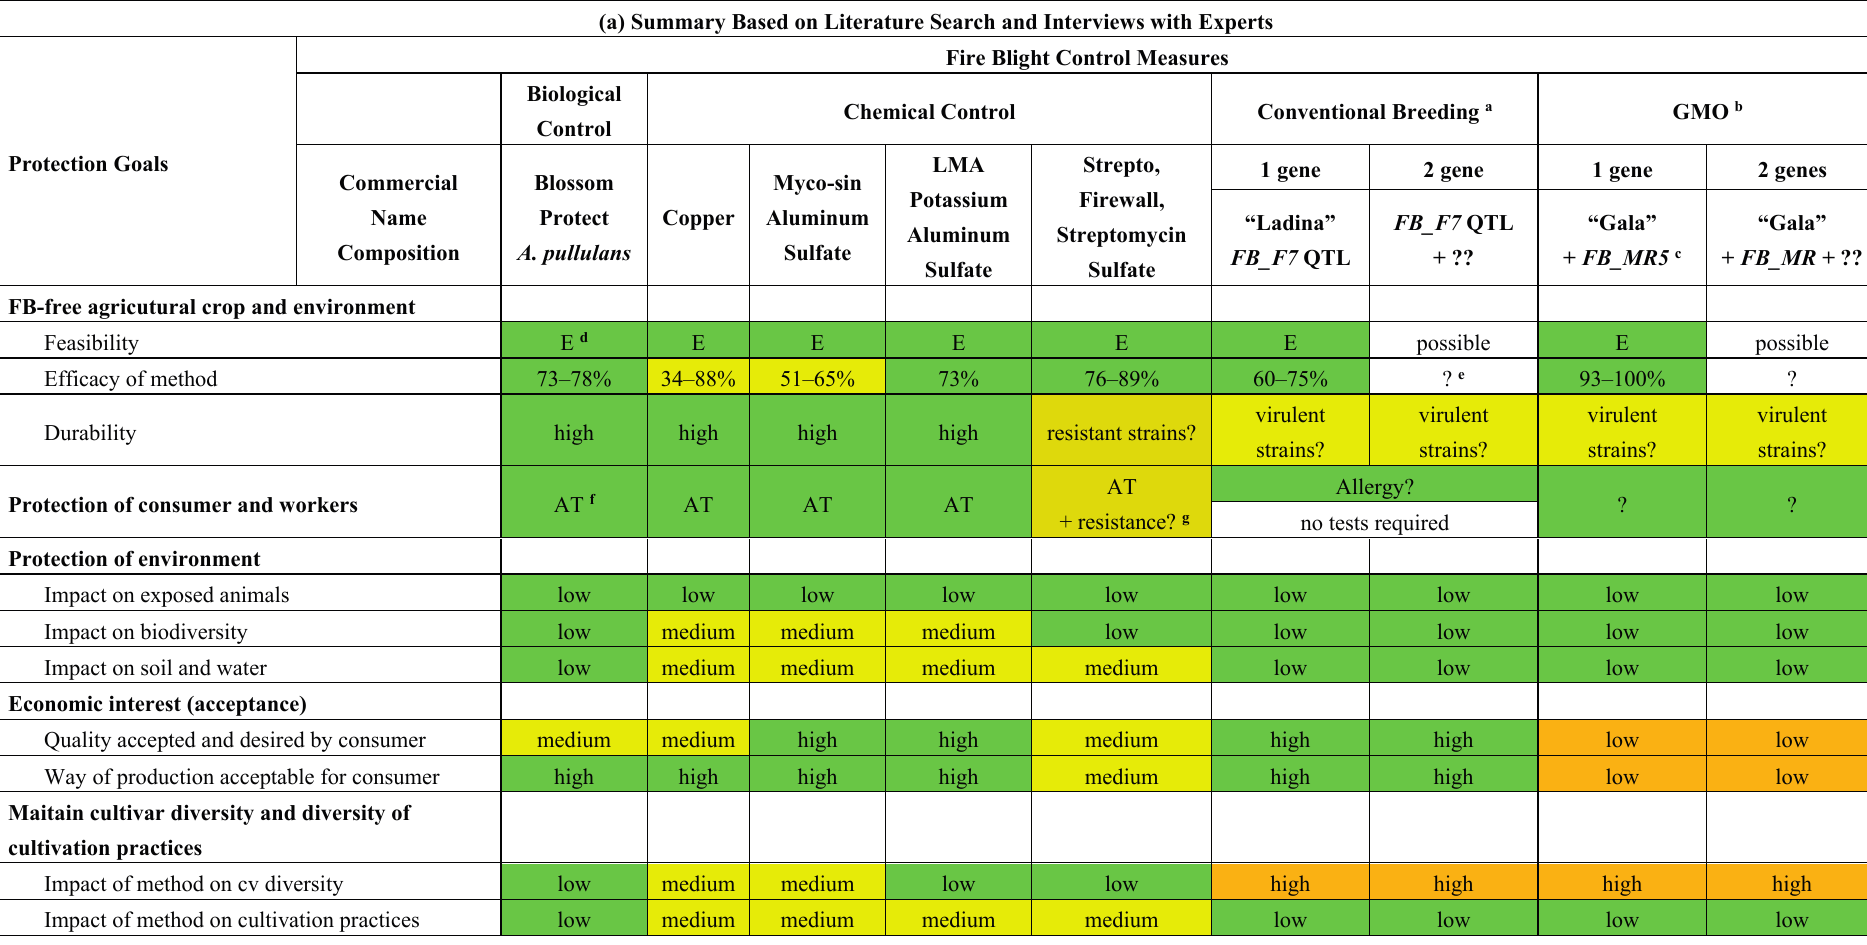
Table 3. Overview of the assessment of fire blight (FB) control methods: classification of identified uncertainties and problems. (a) Summary Based on Literature Search and Interviews with